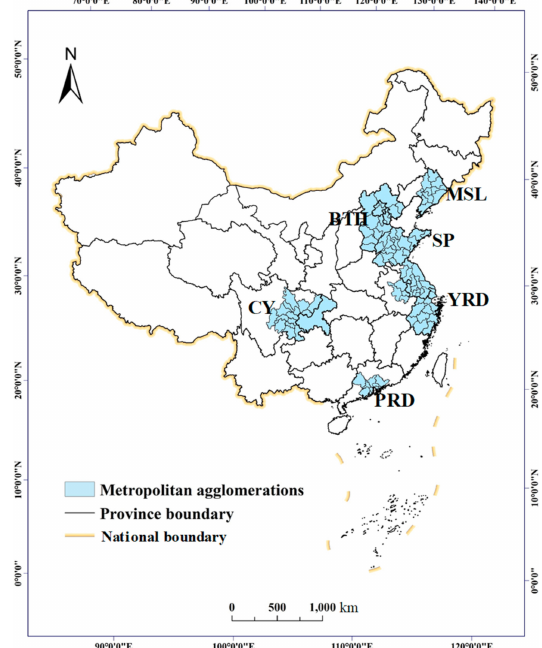
Figure 1. Spatial distribution of the study areas. Note: BTH represents the Beijing-Tianjin-Hebei urban agglomeration; MSL represents the middle and south Liaoning urban agglomeration; SP represents the Shandong Peninsula urban agglomeration; CY represents the Chengdu-Chongqing urban agglomeration; YRD represents the Yangtze River Delta urban agglomeration; and PRD represents the Pearl River Delta urban